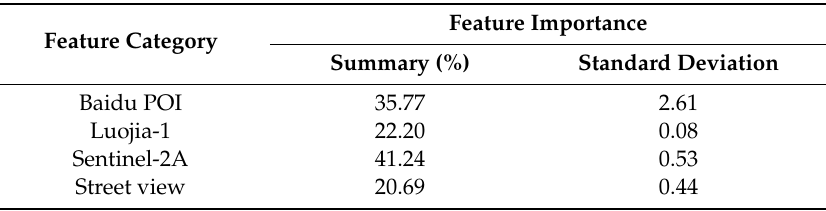
Table 6. Statistics of the importance of the features.